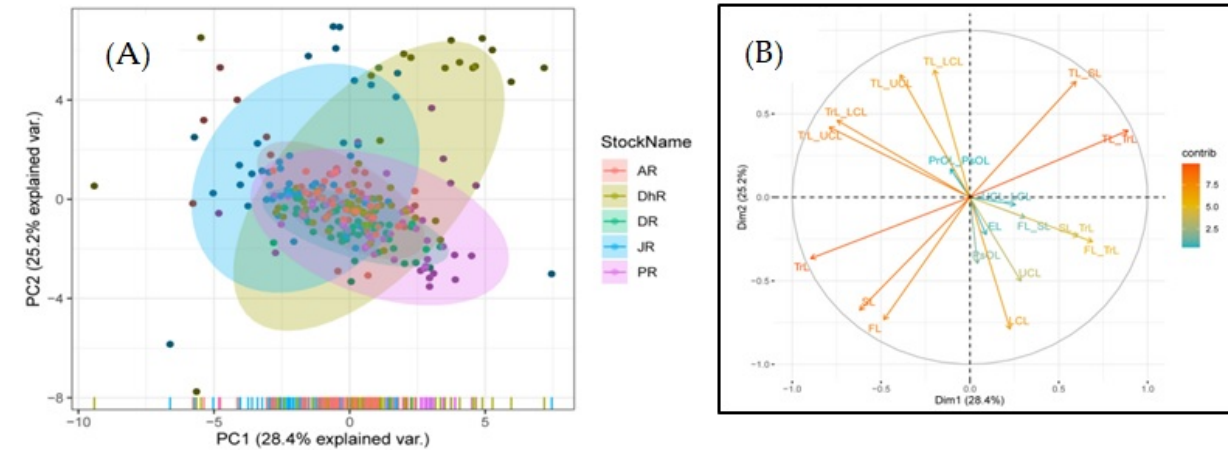
Figure 3. Principal component analysis (PCA) of morphometric data and ratios of Botia dario stocks obtained from five rivers of Bangladesh. ( A ) bi-plots of PCA are shown and ( B ) dimension results represent the loadings of each character.